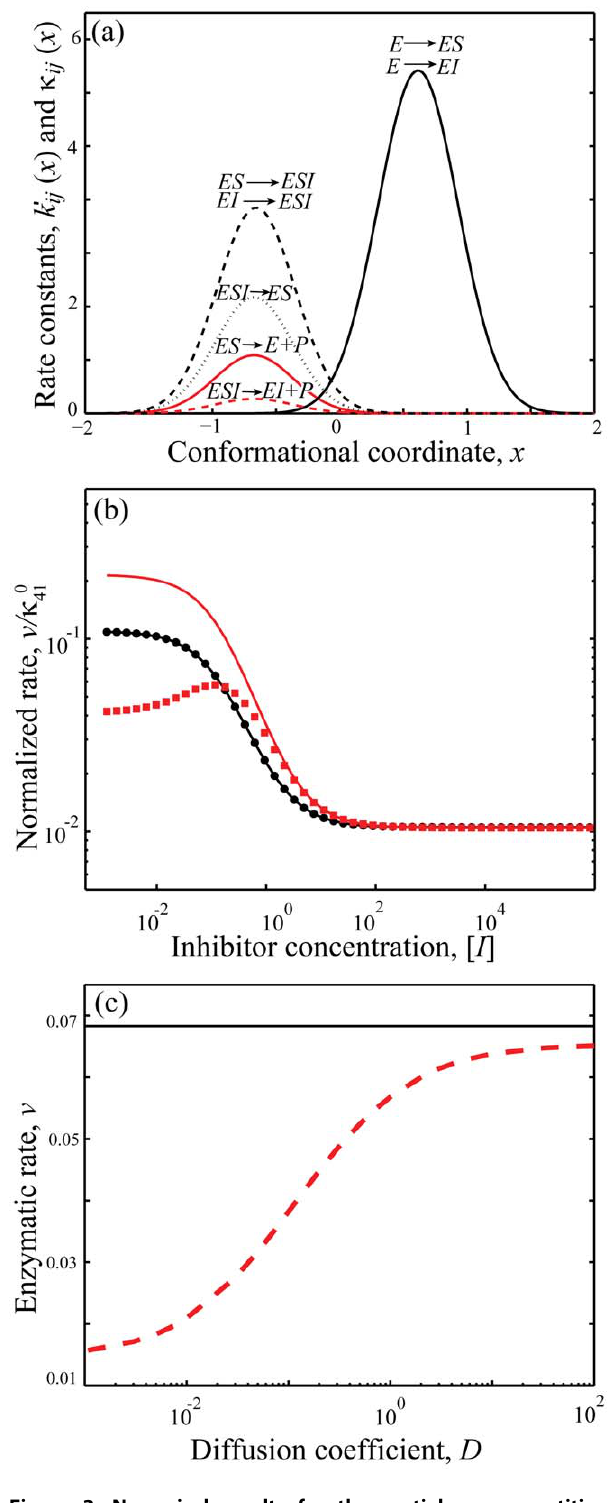
Figure 3. Numerical results for the partial noncompetitive inhibition reaction. a) Rate constants k ij ( x ) and k ij ( x ) as function of the conformational coordinate x , with parameters given in Tables 3 and h i. n o x ð Þ k B T . 4 calculated using Eq. (34) and k ij x ð Þ ~ k 0 exp U i x ð Þ { U { ij ij as a function of concentration [ I ] at a fixed b) Normalized rate v (cid:12) k 0 43 ~ 10 and concentration of [ S ]=1. When catalytic reaction is fast with k 0 21 ~ 0 : 5 Slow diffusion in ES conformation leads to an increase in the k 0 43 rate at low and intermediate inhibitor concentration followed by